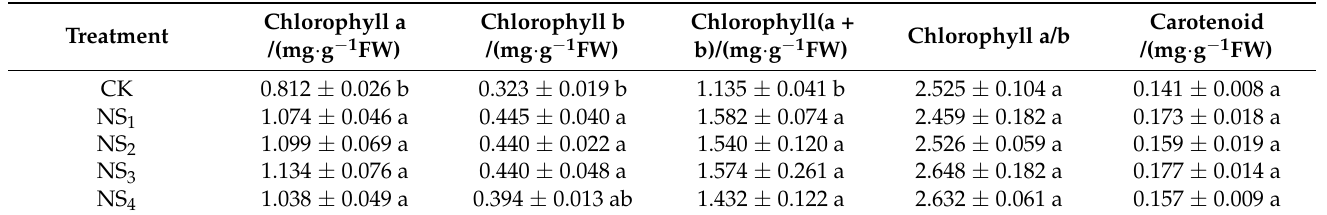
Table 2. Effects of foliage spraying of NaHSO 3 on chlorophyll content in O. violaceus leaves.